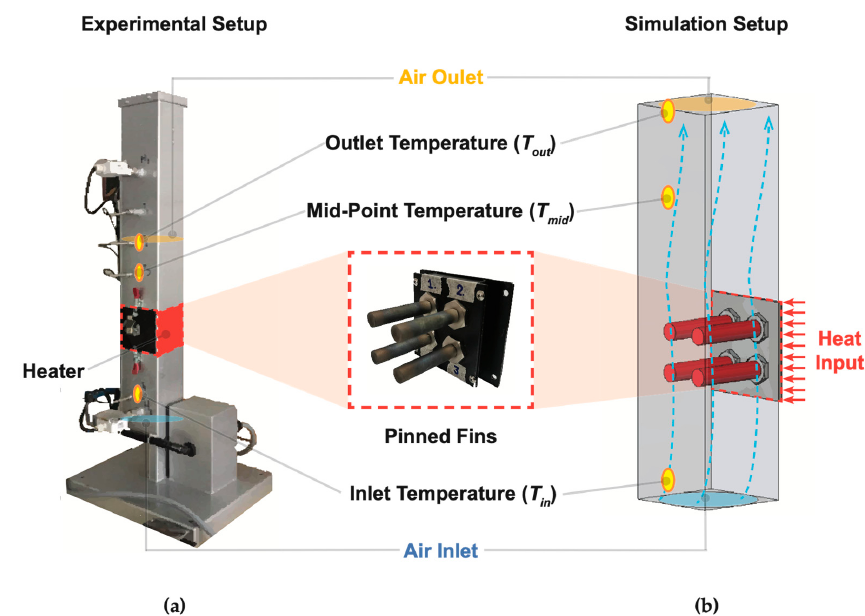
Figure 1. The heat transfer performance testing apparatus: ( a ) Experimental setup; ( b ) Simulation setup. Table 1. Material properties of the 316L stainless steel tube considered in this study.